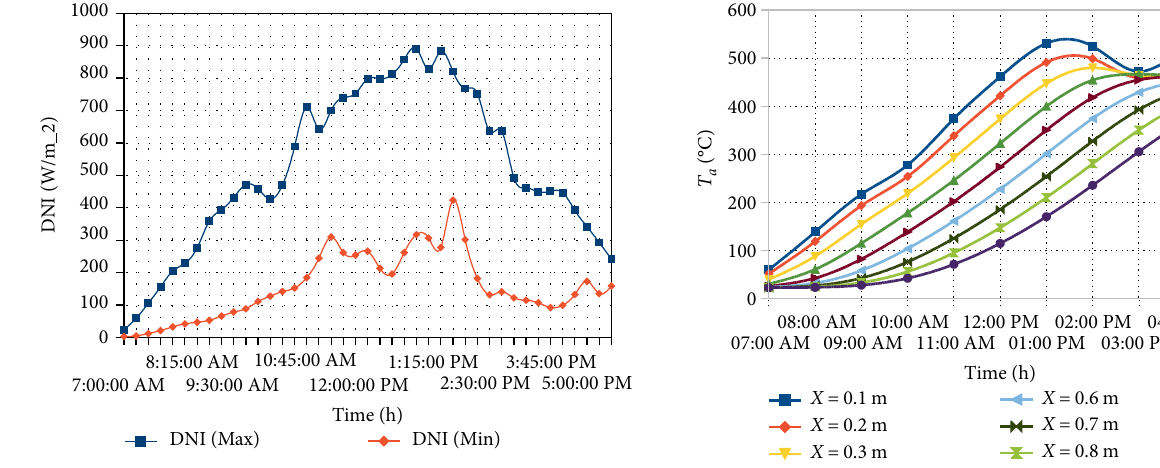
Figure 8: Direct normal irradiance for maximum and minimum in the year with respect to time (7 AM to 5 PM).